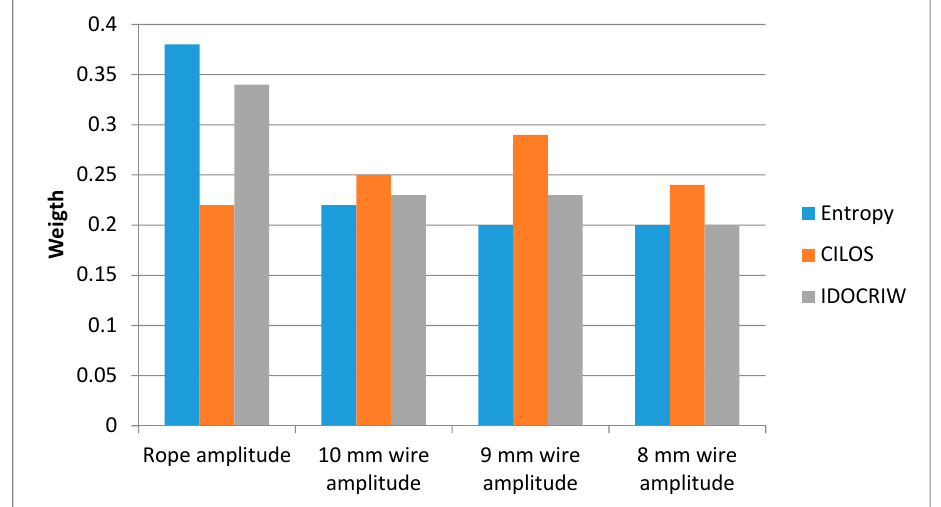
Figure 5. Results of the criteria weight distribution for entropy, Criterion Impact Loss (CILOS) and Integrated Determination of Objective Criteria Weights (IDOCRIW) methods for a 60 Hz vibration frequency.